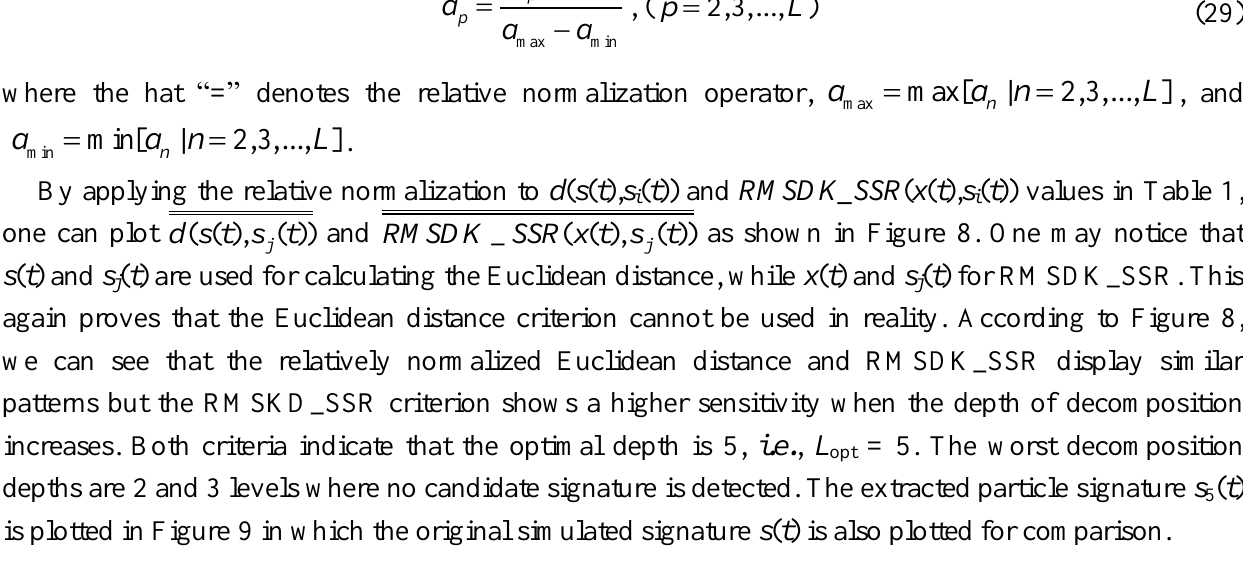
Figure 8. Relatively normalized Euclidian distance and RMSDK_SSR.